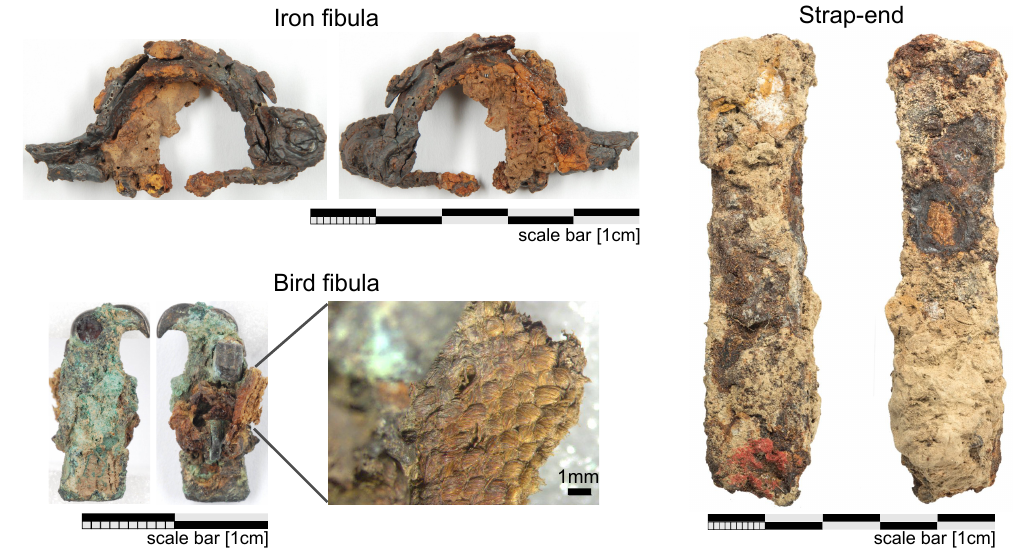
Figure 4. Photography of the examined archaeological findings: Iron fibula, strap-end and bird fibula. Photographies provided by the Bavarian State Office for Heritage Management (BLfD), Tracy Niepold, Julia Ziegler, Helmut